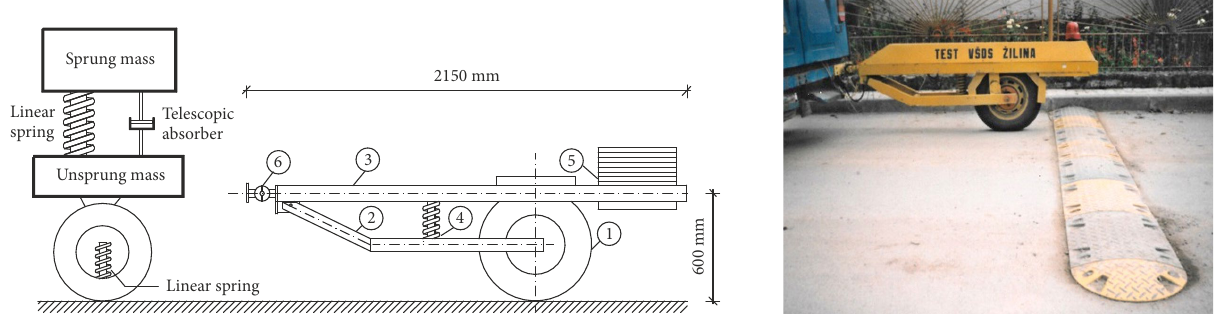
Figure 2. Basic scheme of a UNIZA single-wheel vehicle JP VSDS: 1 – front wheel with a S 120 charge; 2 – bottom frame; 3 – upper frame; 4 – spring and telescopic shock absorber S 120; 5 – balancing load; 6 – cardan joint